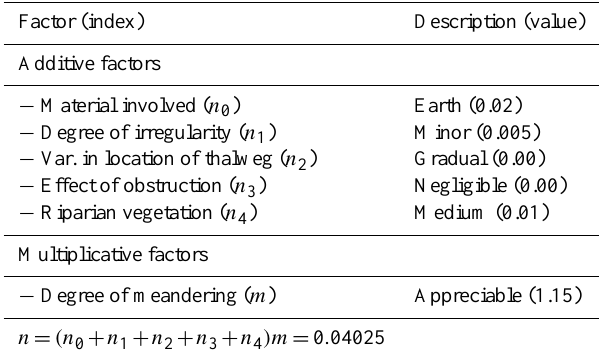
Table 2. Results of the three validation surveys of the DSM and the IVM methods. Q BS denotes the discharge calculated from the boat survey, which can be considered